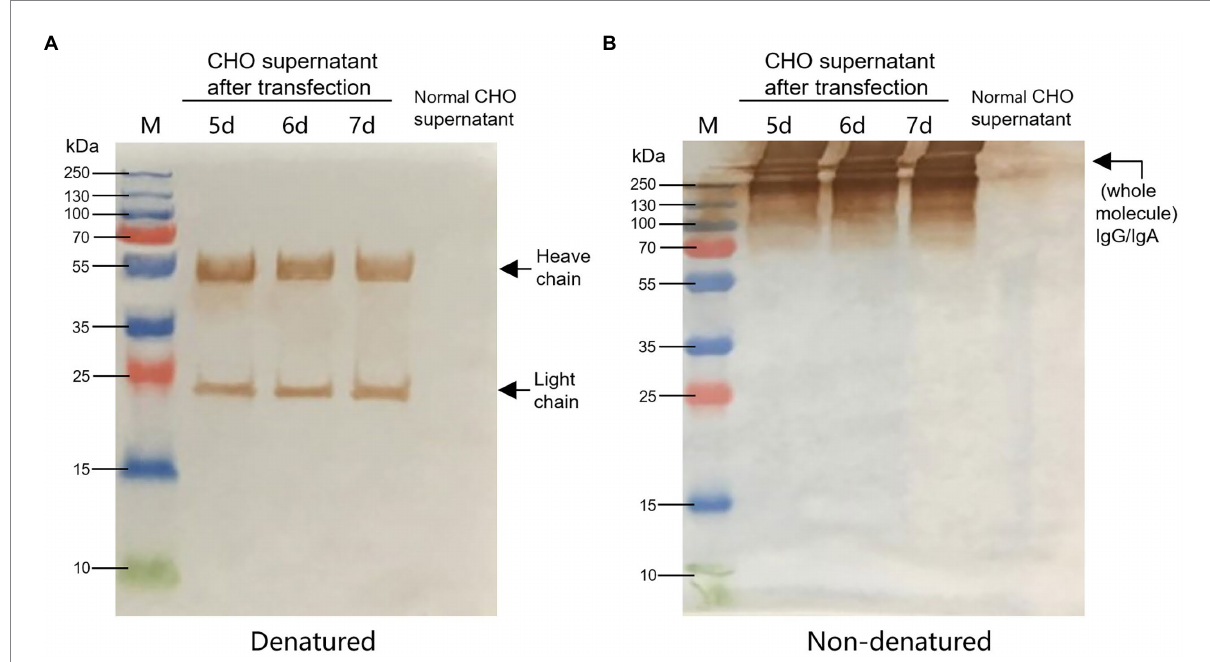
FIGURE 2 Identification of CHO-expressed chimeric IgG/IgA. Western blot analysis of CHO-expressed chimeric IgG/IgA under reducing conditions (A) and non-reducing conditions (B) in the 5, 6 and 7 dpt. Black arrows indicated the heavy and light chains.